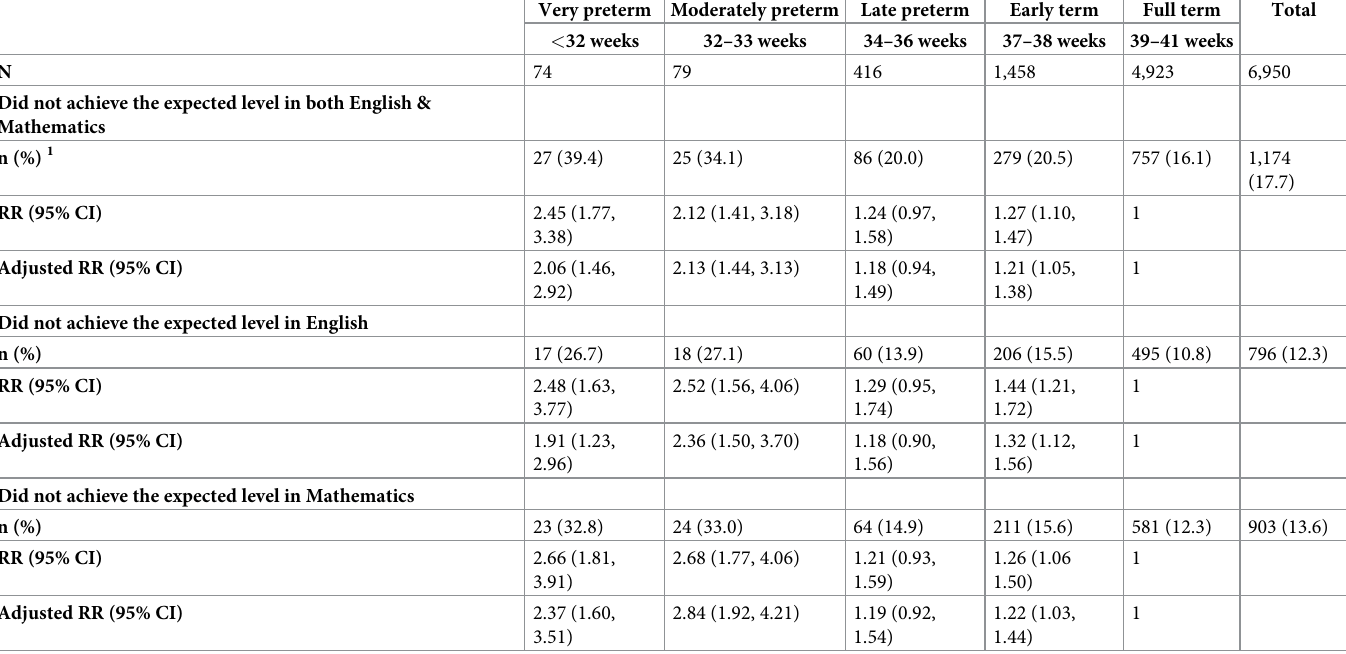
Table 4. The association between gestational age at birth and educational outcomes at the end of primary school (Key Stage 2; age 11) within the Millennium Cohort Study